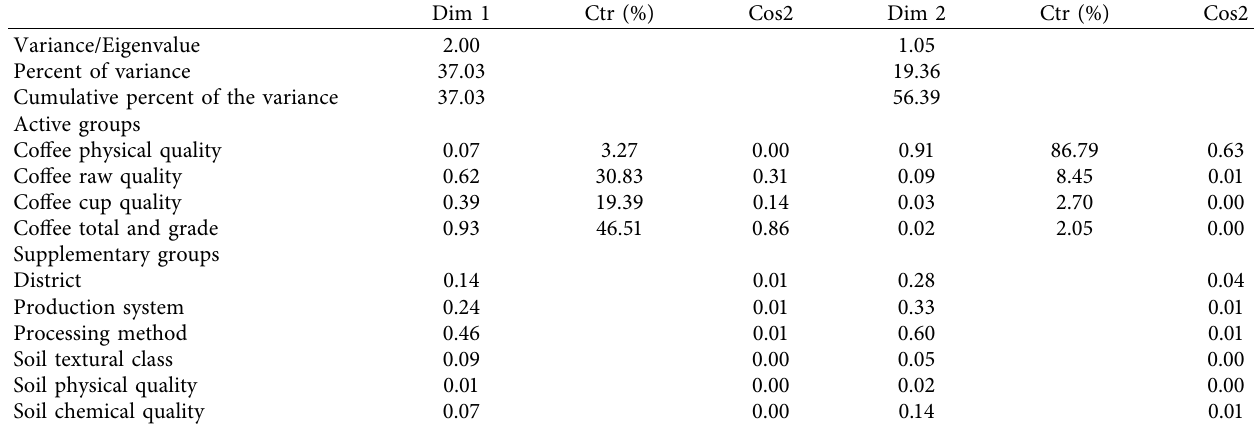
Table 2: Eigenvalues, coordinates, variable contribution, and squared cosine values of active and supplementary group